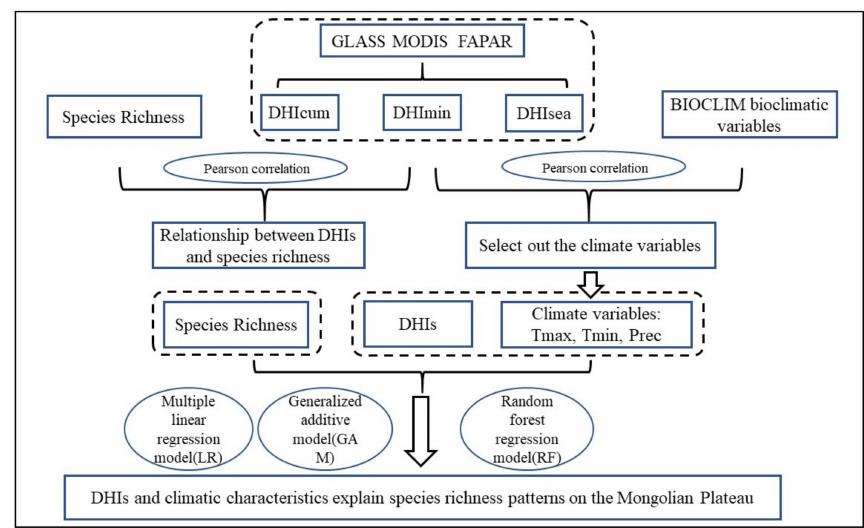
Figure 2. Flowchart showing the data analysis procedure for the DHIs and species richness based on remote sensing